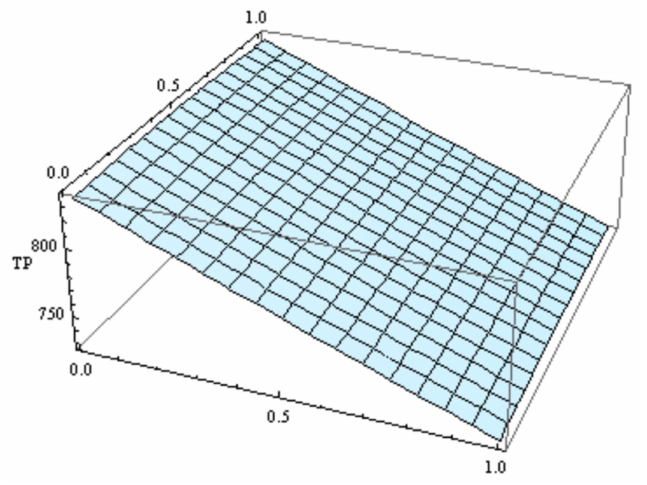
Figure 2. The total profit per unit time TP ( s ∗ , t ∗ n , r ) for application